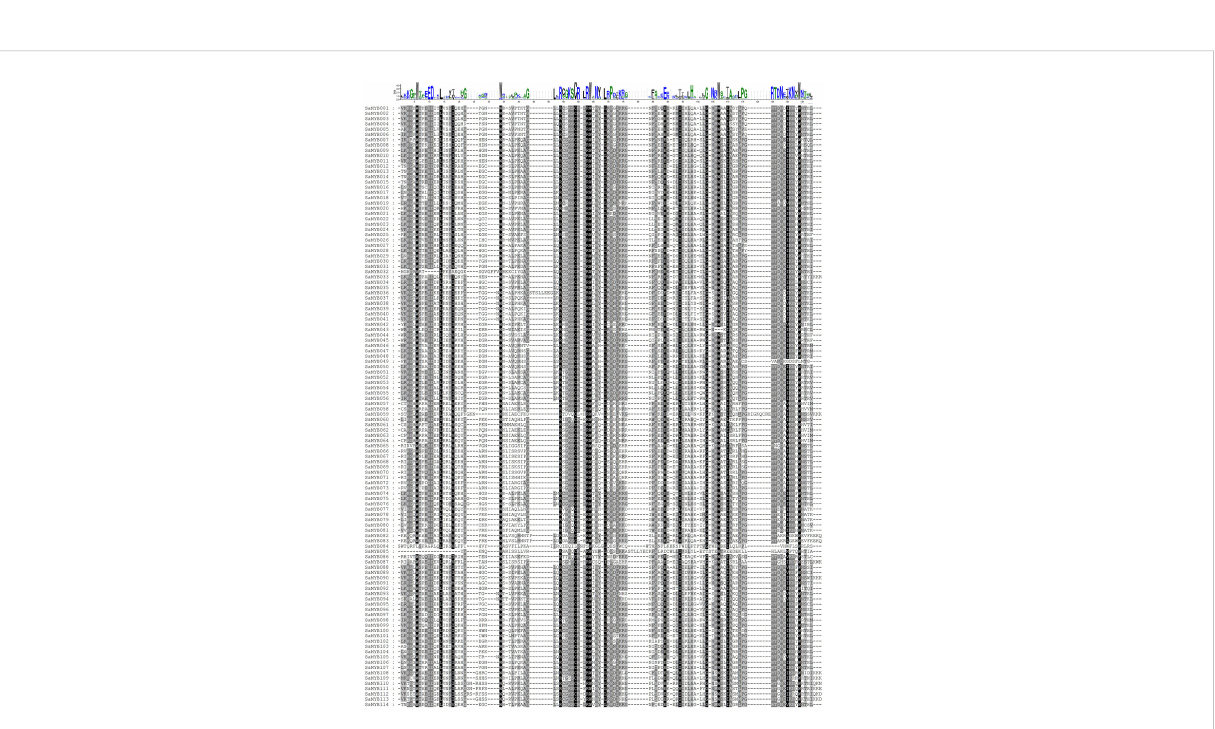
FIGURE 2 Results of conserved motifs and sequence alignment analyses of 114 R2R3-MYB proteins in S.album